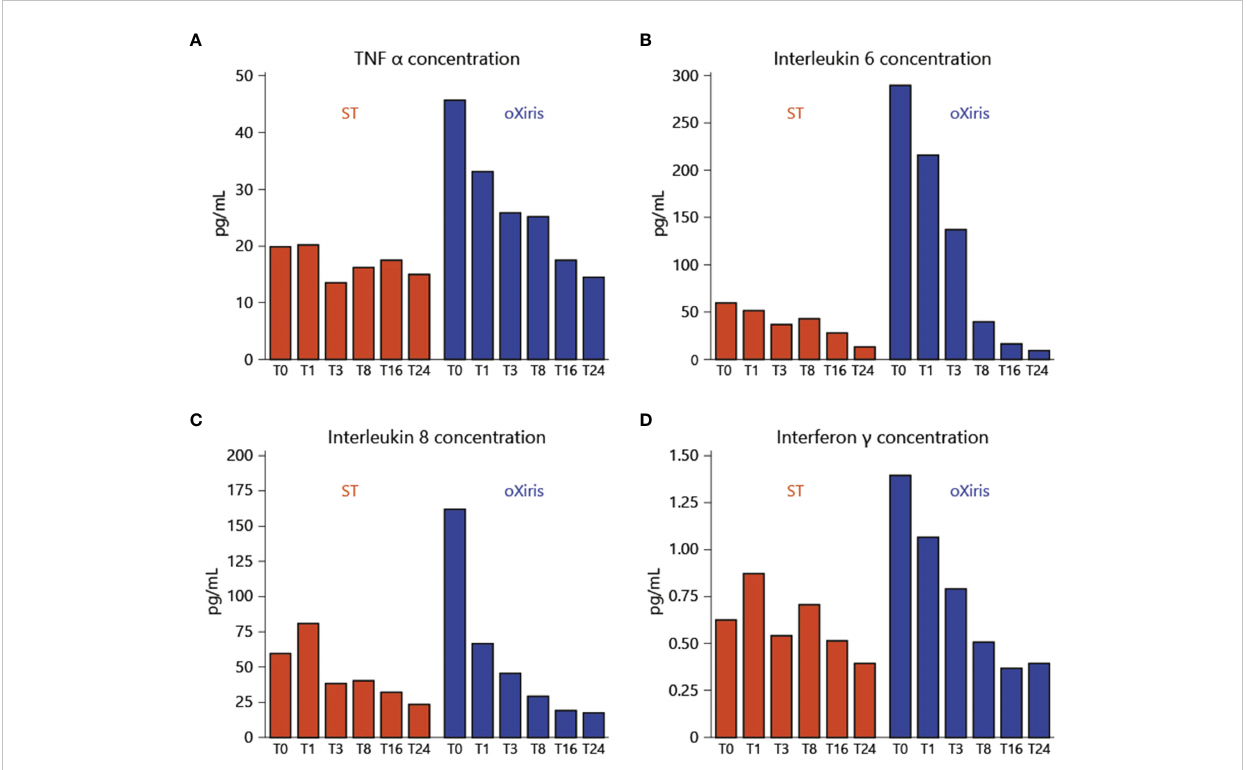
FIGURE 4 In fl ammatory mediator levels before the beginning of treatment and throughout the fi ltration treatment via oXiris membrane: (A) TNF- a ; (B) Interleukin-6 (IL-6); (C) Interleukin-8 (IL-8); (D) Interferon- g . Reproduced with permission from